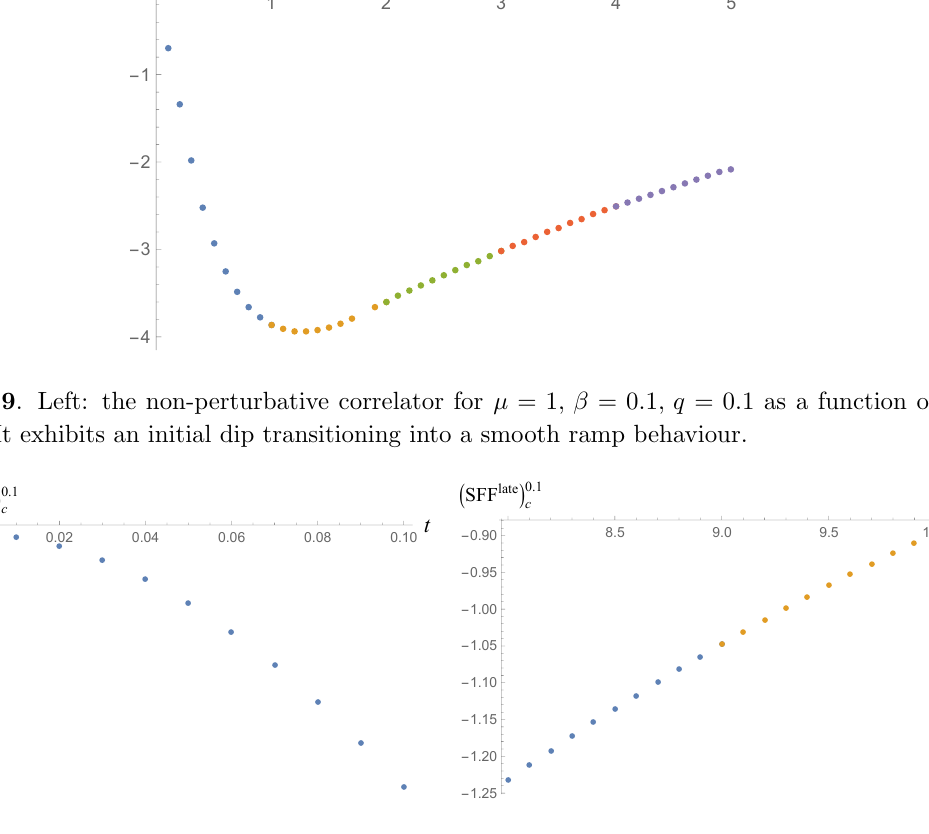
Figure 10 . Left: the early time behaviour of the exact correlator for (cid:22) = 1 ; (cid:12) = 0 : 1 ; q = 0 : 1. Right: zooming in the late time behaviour. The behaviour is smooth, in contrast with the q = 0 SFF. We expect the correlator to saturate in a plateau but we cannot access this very late time regime t (cid:29) 10 with our